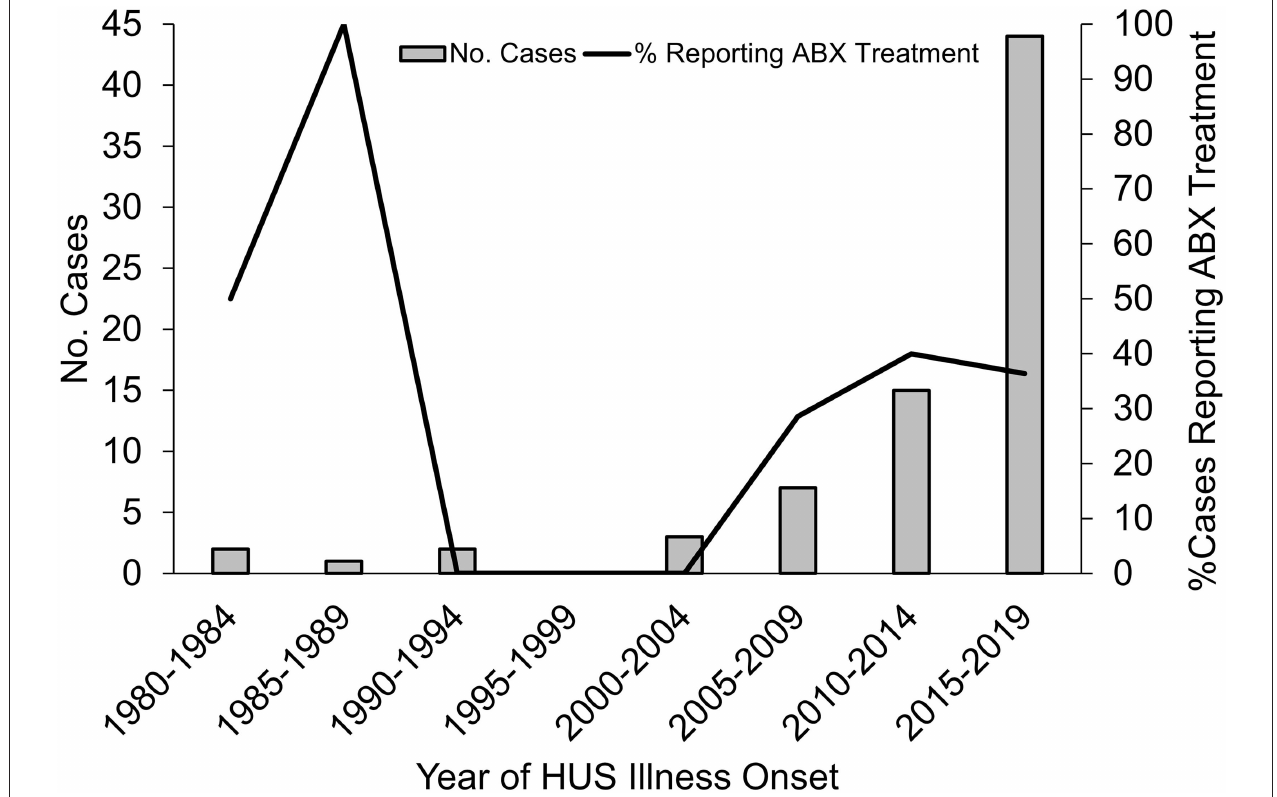
FIGURE 1 | Self-reported antibiotic treatment among HUS cases by year of illness onset. HUS, hemolytic uremic syndrome; ABX, antibiotic; STEC, Shiga toxin–producing E. coli . Report of antibiotic treatment refers to treatment at any point during the acute illness phase and does not distinguish between treatment before and/or after diagnosis with STEC or